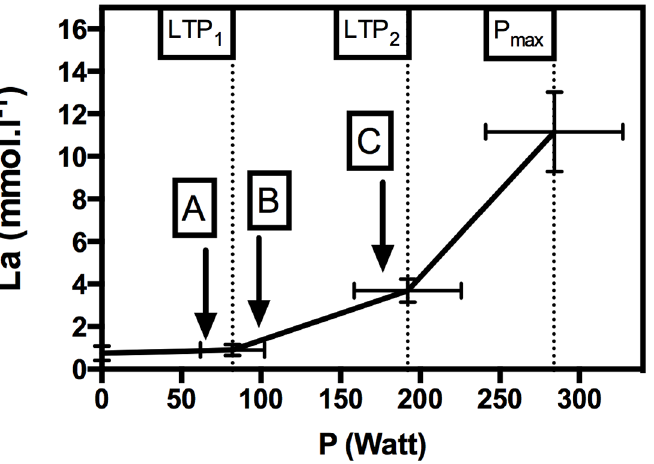
Fig 3. Blood lactate (La) performance curve during the incremental exercise test. A, B, and C represent the target mean loads for both continuous exercise and high-intensity interval exercise. LTP 1 : first lactate turn point; LTP 2 : second lactate turn point; P max : maximal power output. Values are given as mean and